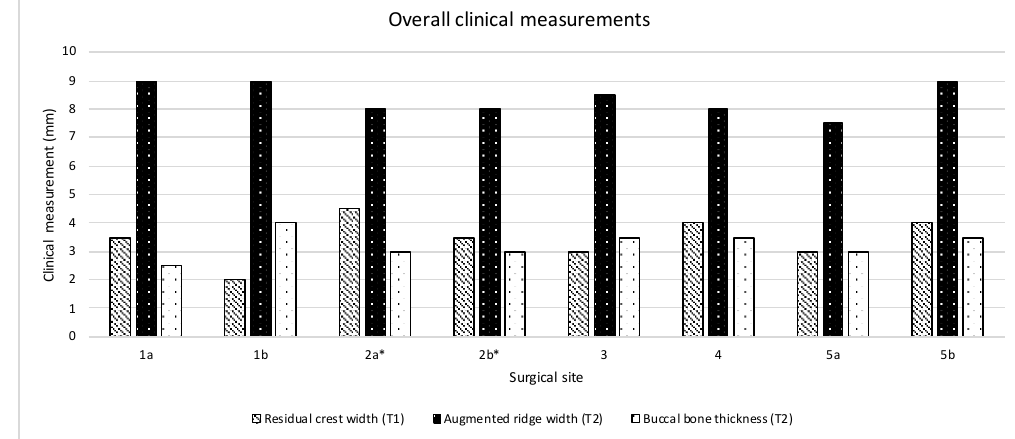
Figure 9. Graphical representation of the clinical measurements registered at each surgical site during the surgical procedure (T1) and after 8 months (T2); *surgical site that showed membrane exposure. The mean width of the residual alveolar ridge at the coronal portion of the crest measured at T1 was 3.43 ± 0.77. After implant insertion, the analysis of the defect configuration showed a mean vertical defect height of 3.5 ± 0.75, and a mean horizontal defect width of 3.5 ± 0.50 mm. At T2, the mean crestal width of the augmented alveolar ridge was 8.38 ± 0.58 mm, corresponding to a mean horizontal bone gain of 4.95 ± 0.96 mm. The mean horizontal thickness of the buccal plate was 3.25 ± 0.46 mm. In most of the patients, no residual defects were found at T2. Only the patient experiencing titanium mesh exposure showed a residual dehiscence of approximately 1 mm in height and 0.5 mm in width at the buccal aspect of both surgical sites. The radiographic measurements at each surgical site were represented in Figure 10.